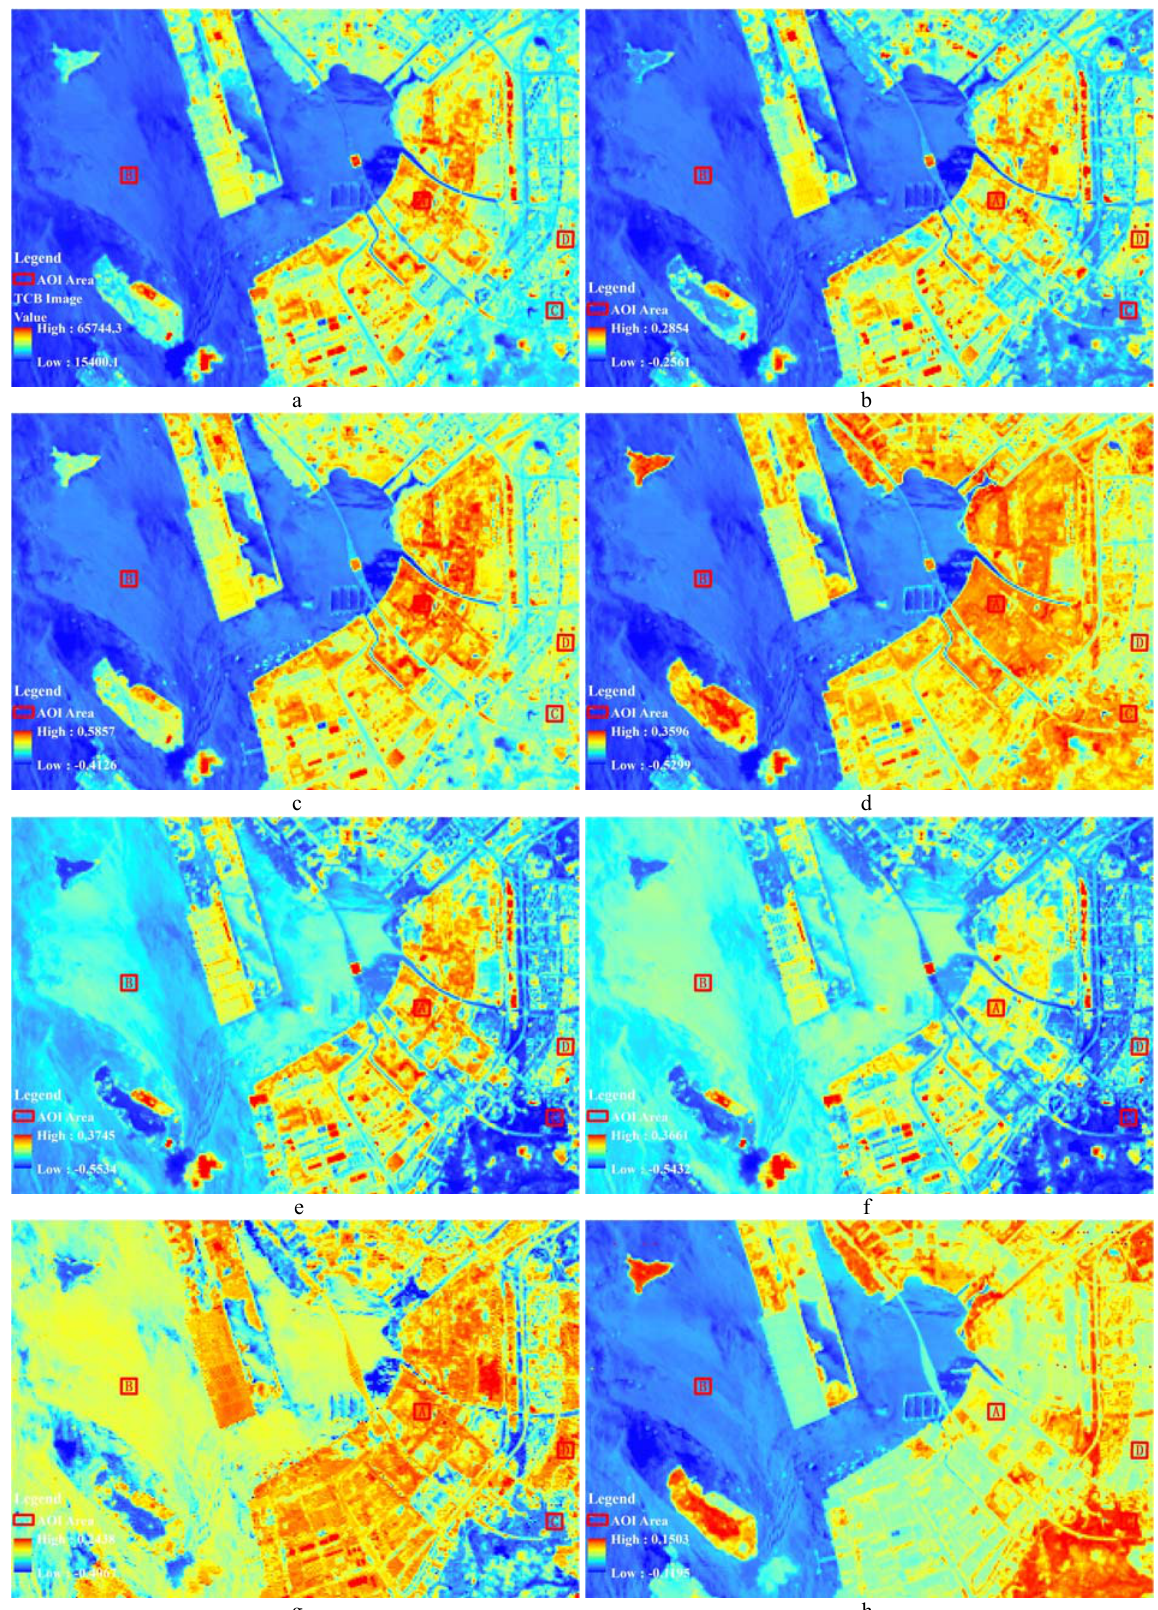
Figure 4. Results of TCB (a) and NDBaI1-7 (b~h) for Shekou Peninsula in